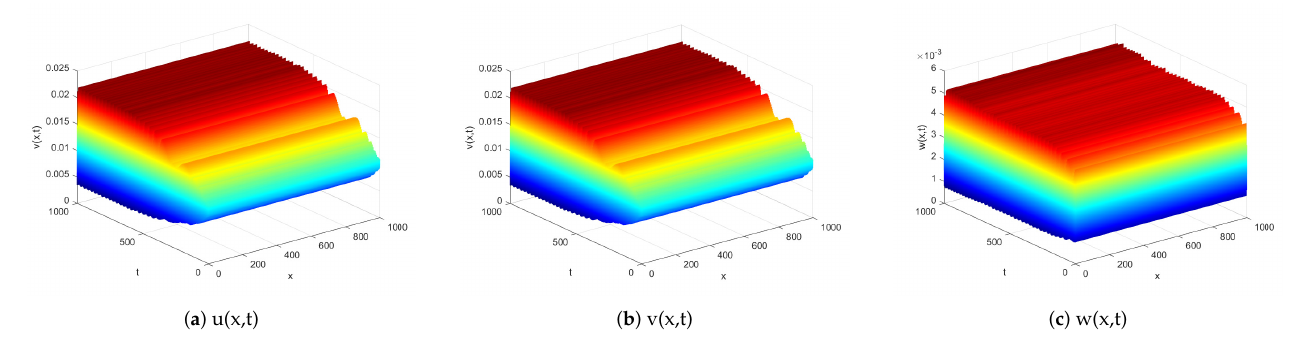
Figure 1. When d 1 = d 2 = d 3 , ( u p ( t ), v p ( t ), w p ( t )) remains stable in the diffusive system (3).